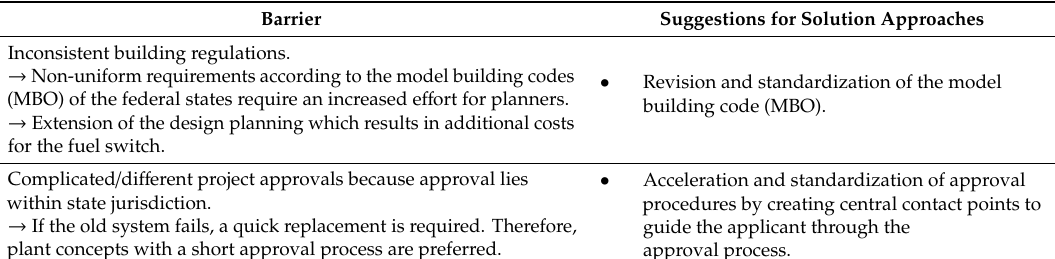
Table 4. Deficits in planning and approval processes and approaches to further expand of bioheat concepts (based on [42], including some